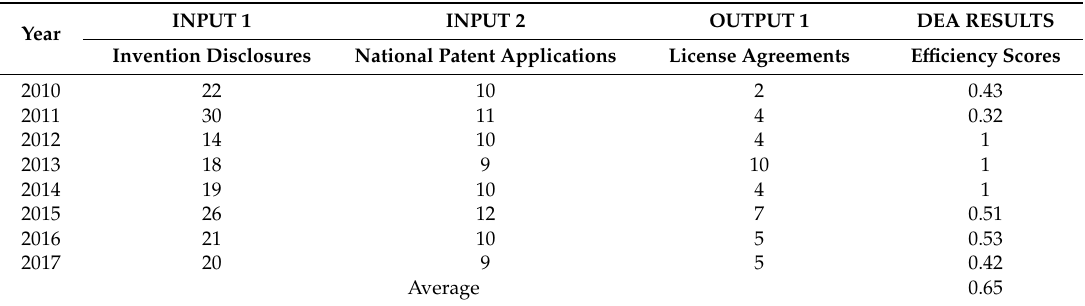
Table 3. Technology transfer o ffi ce (TTO) alpha performance metrics for 2010–2017 and DEA